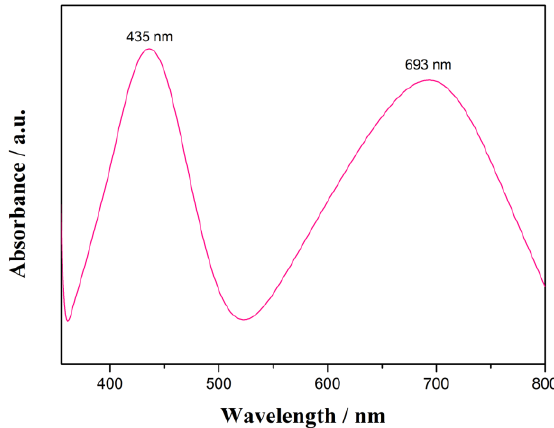
Figure 3. Ultraviolet-visible spectroscopy (UV-Vis) spectrum of the ball-like Ag nanorod aggregates.